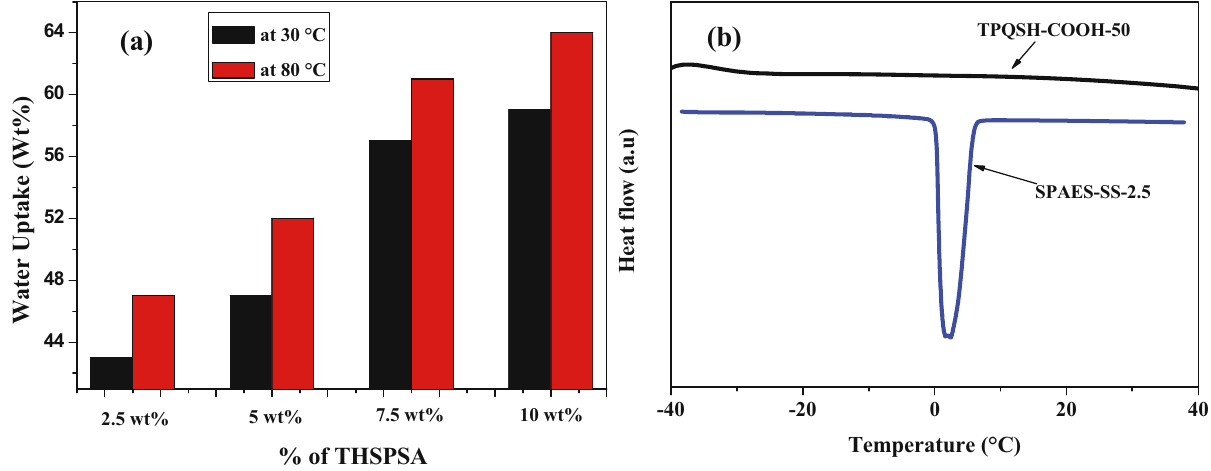
Figure 6: ( a ) Variation in the water uptake ( wt% ) with % of THSPSA at di ff erent temperatures of SPAES - SS - X composite membranes. ( b ) DSC melting curves of water - swollen membranes of TPQSH - COOH - 50 and SPAES - SS -